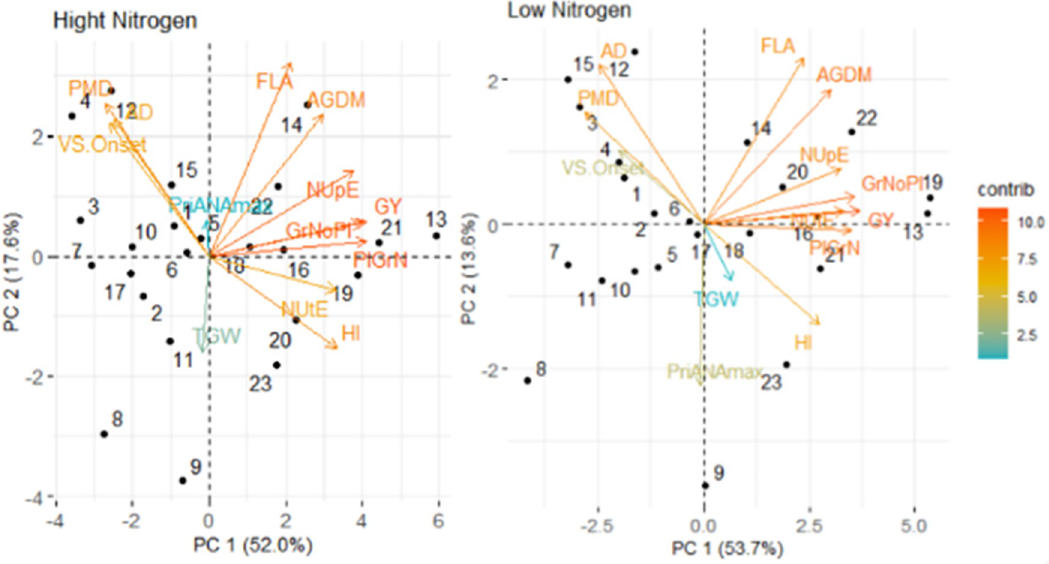
Fig 5. Biplot for 22 genotypes (18 amphidiploid lines and 4 parents) under High N and Low N conditions (mean of 2015 and 2016) for grain yield plant -1 (GY), above-ground dry matter plant -1 (AGDM), harvest index (HI), days to anthesis (AD), physiological maturity date (PMD), thousand grain weight (TGW), grain number plant -1 (GrNoPl), grain N plant -1 (PlGrN), N-utilization efficiency (NUtE), N-uptake effciency (NUpE), flag-leaf area (FLA), visual senescence onset (VS.Onset), and pre- anthesis flag-leaf A max (PreANA max